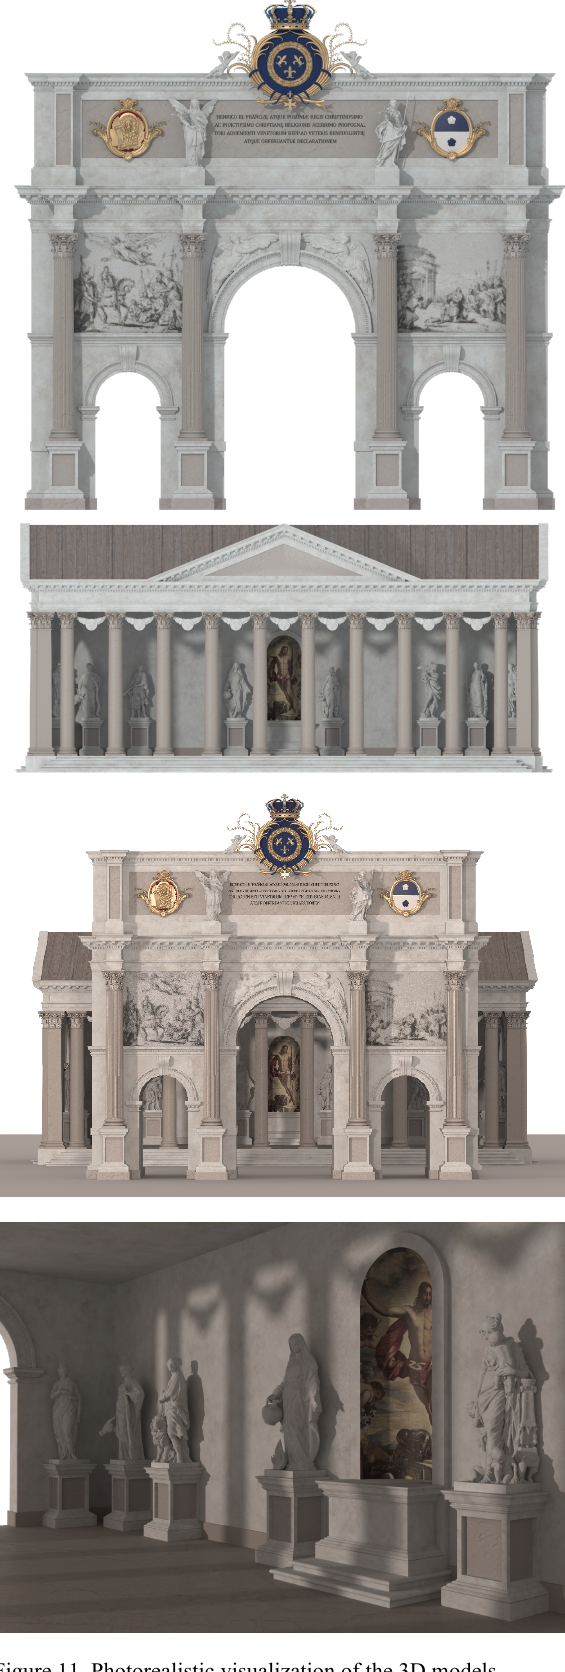
Figure 11. Photorealistic visualization of the 3D